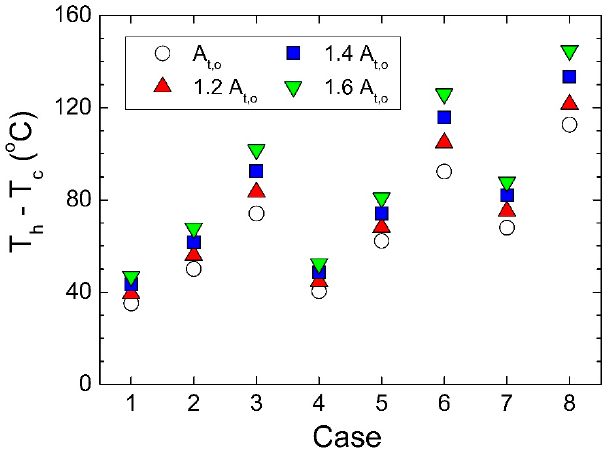
Figure 9. Temperature differences at both hot and cold sides of the TEM for the cases shown in Figure 3 when using heat absorbers with different total surface area A t . Numerical results.